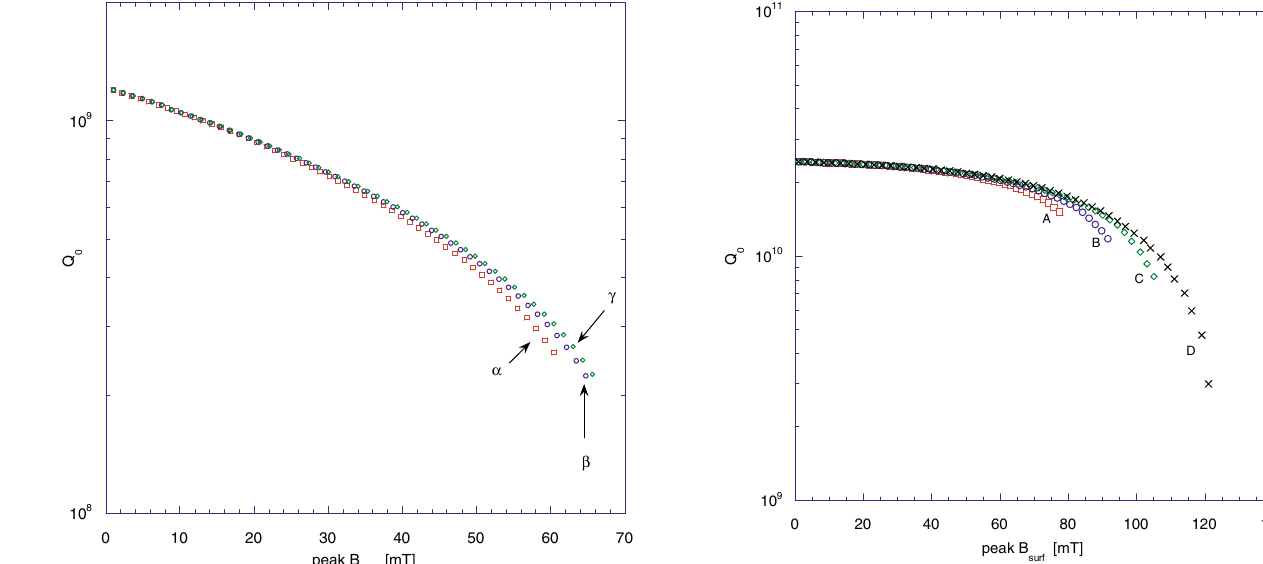
FIG. 8. (Color) Simulation of a TRASCO 700 MHz cavity at 4.2 K with pipe cooling. The cavity is covered with nine pipes for a total of 20% of its surface. The curves relate to different Cu thickness. Curve ( (cid:7) ): thickness (cid:3) 2 mm ; curve ( (cid:11) ): thickness (cid:3) 6 mm ; curve ( % ): thickness (cid:3) 10 mm .